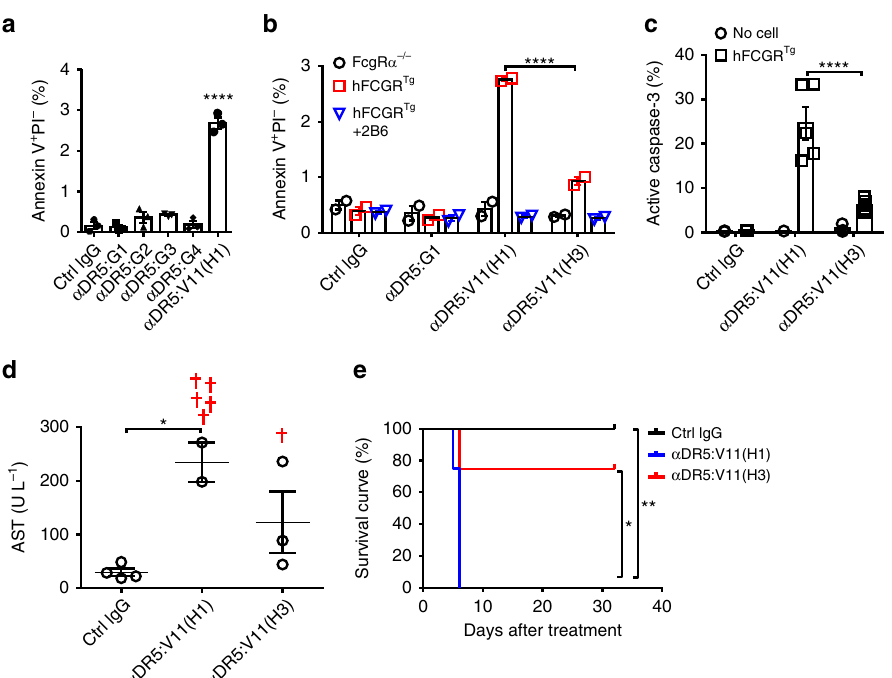
Fig. 7 The detrimental effect of IgG3 CH1-hinge on anti-DR5 antibody agonism. a – c Quanti fi cation of the percentage of Annexin V + PI − ( a , b ) or active caspase-3-positive ( c ) apoptotic cells among MC38 cells co-cultured with Fc γ R-humanized ( a – c ), Fcgr α − / − ( b ), or without ( c ) mouse splenocytes for 4 h in the presence of indicated control IgG or anti-DR5 mAbs ( a – c ) with/without human Fc γ RIIB-blocking antibody 2B6 ( b ). d Quanti fi cation of AST levels in Fc γ R-humanized mice treated with indicated control or anti-DR5 antibodies 6 days earlier (crosses symbolize mortality). e Survival curve of mice in ( d ). Numbers of mice: d , e four mice per group except for seven mice in the α DR5:V11(H1) group. Bars represent the mean ± SEM. * p ≤ 0.05, ** p ≤ 0.01, *** p ≤ 0.001, **** p ≤ 0.0001, one-way ANOVA Sidak ’ s multiple comparisons test ( a ), two-way ANOVA Sidak ’ s multiple comparisons test ( b , c ), and Gehan – Breslow – Wilcoxon test ( d ). Source data are provided as a Source Data fi le. A representative of three ( a – c ), or two ( d , e ) independent